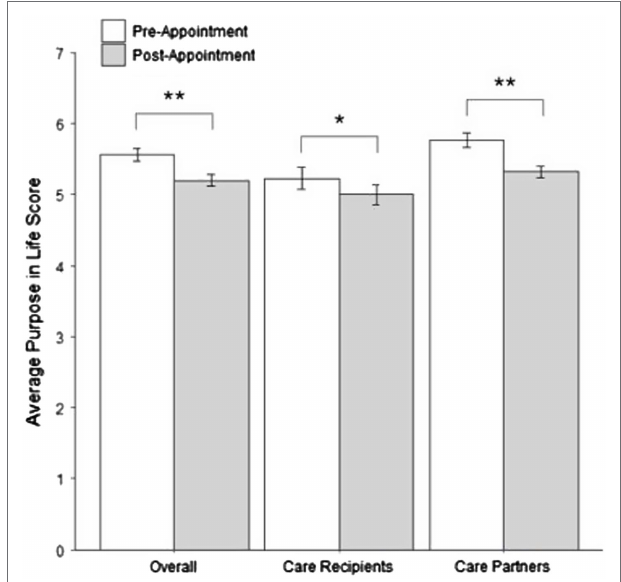
FIGURE 1 | Change in self-reported purpose for care recipients and care partners.